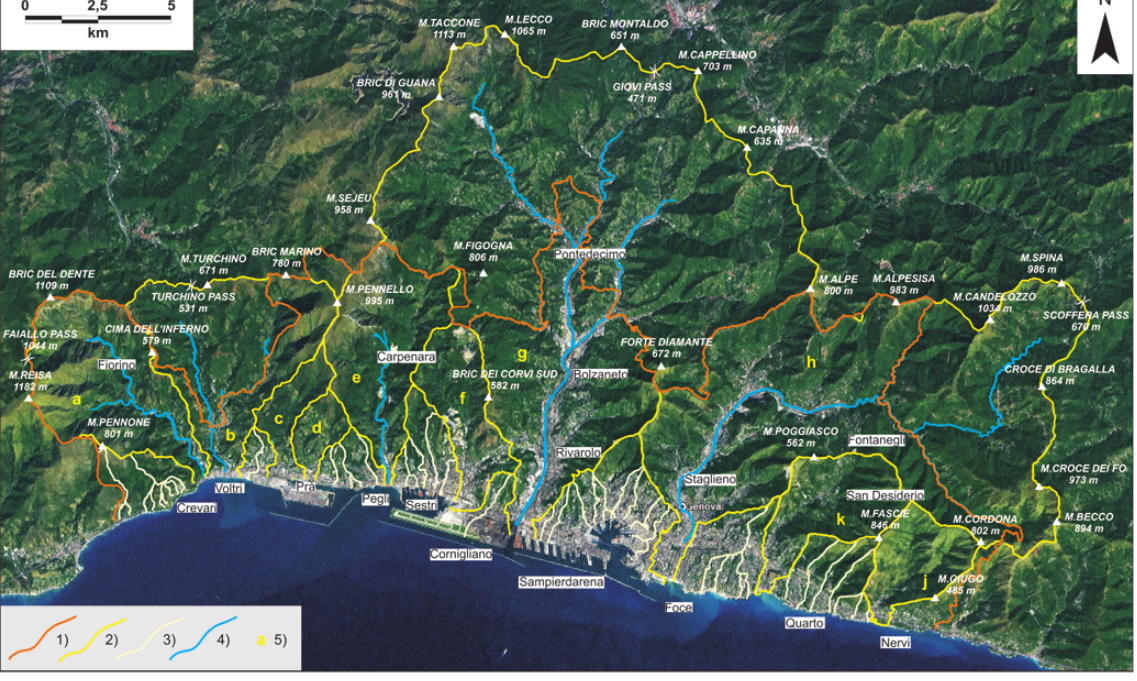
Nat. Hazards Earth Syst. Sci., 12, 943–959,